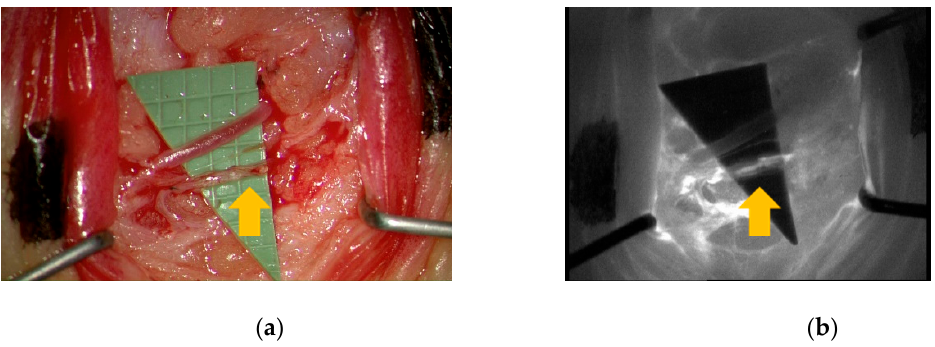
Figure 6. The incision site for surgery was marked with the help of a custom-made pointer.